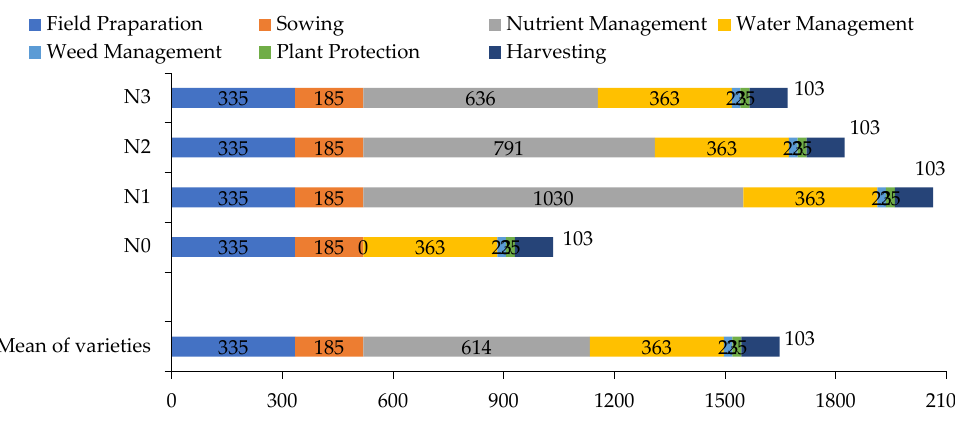
Figure 9. Operation-wise equivalent carbon emission (kg CO 2 -e ha −1 ) for fodder maize varieties sown under different nutrient management practices (mean of two years).